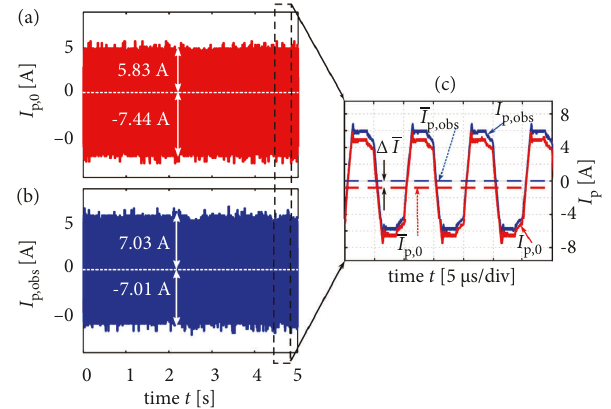
Figure 12: Experimental results of PSFB prototype in steady state operating point. (a) shows the primary current without ctr Ih . The leads to a negative offset resulting asymmetrical course of I p , 0 I < 0. In (b) ctr Ih compensates the offset I ≈ 0 and ensures a p , 0 p , obs symmetrical course of magnetizing current. (c) explains the courses of primary currents in detail and illustrates the offset difference Δ I � − 806 mA